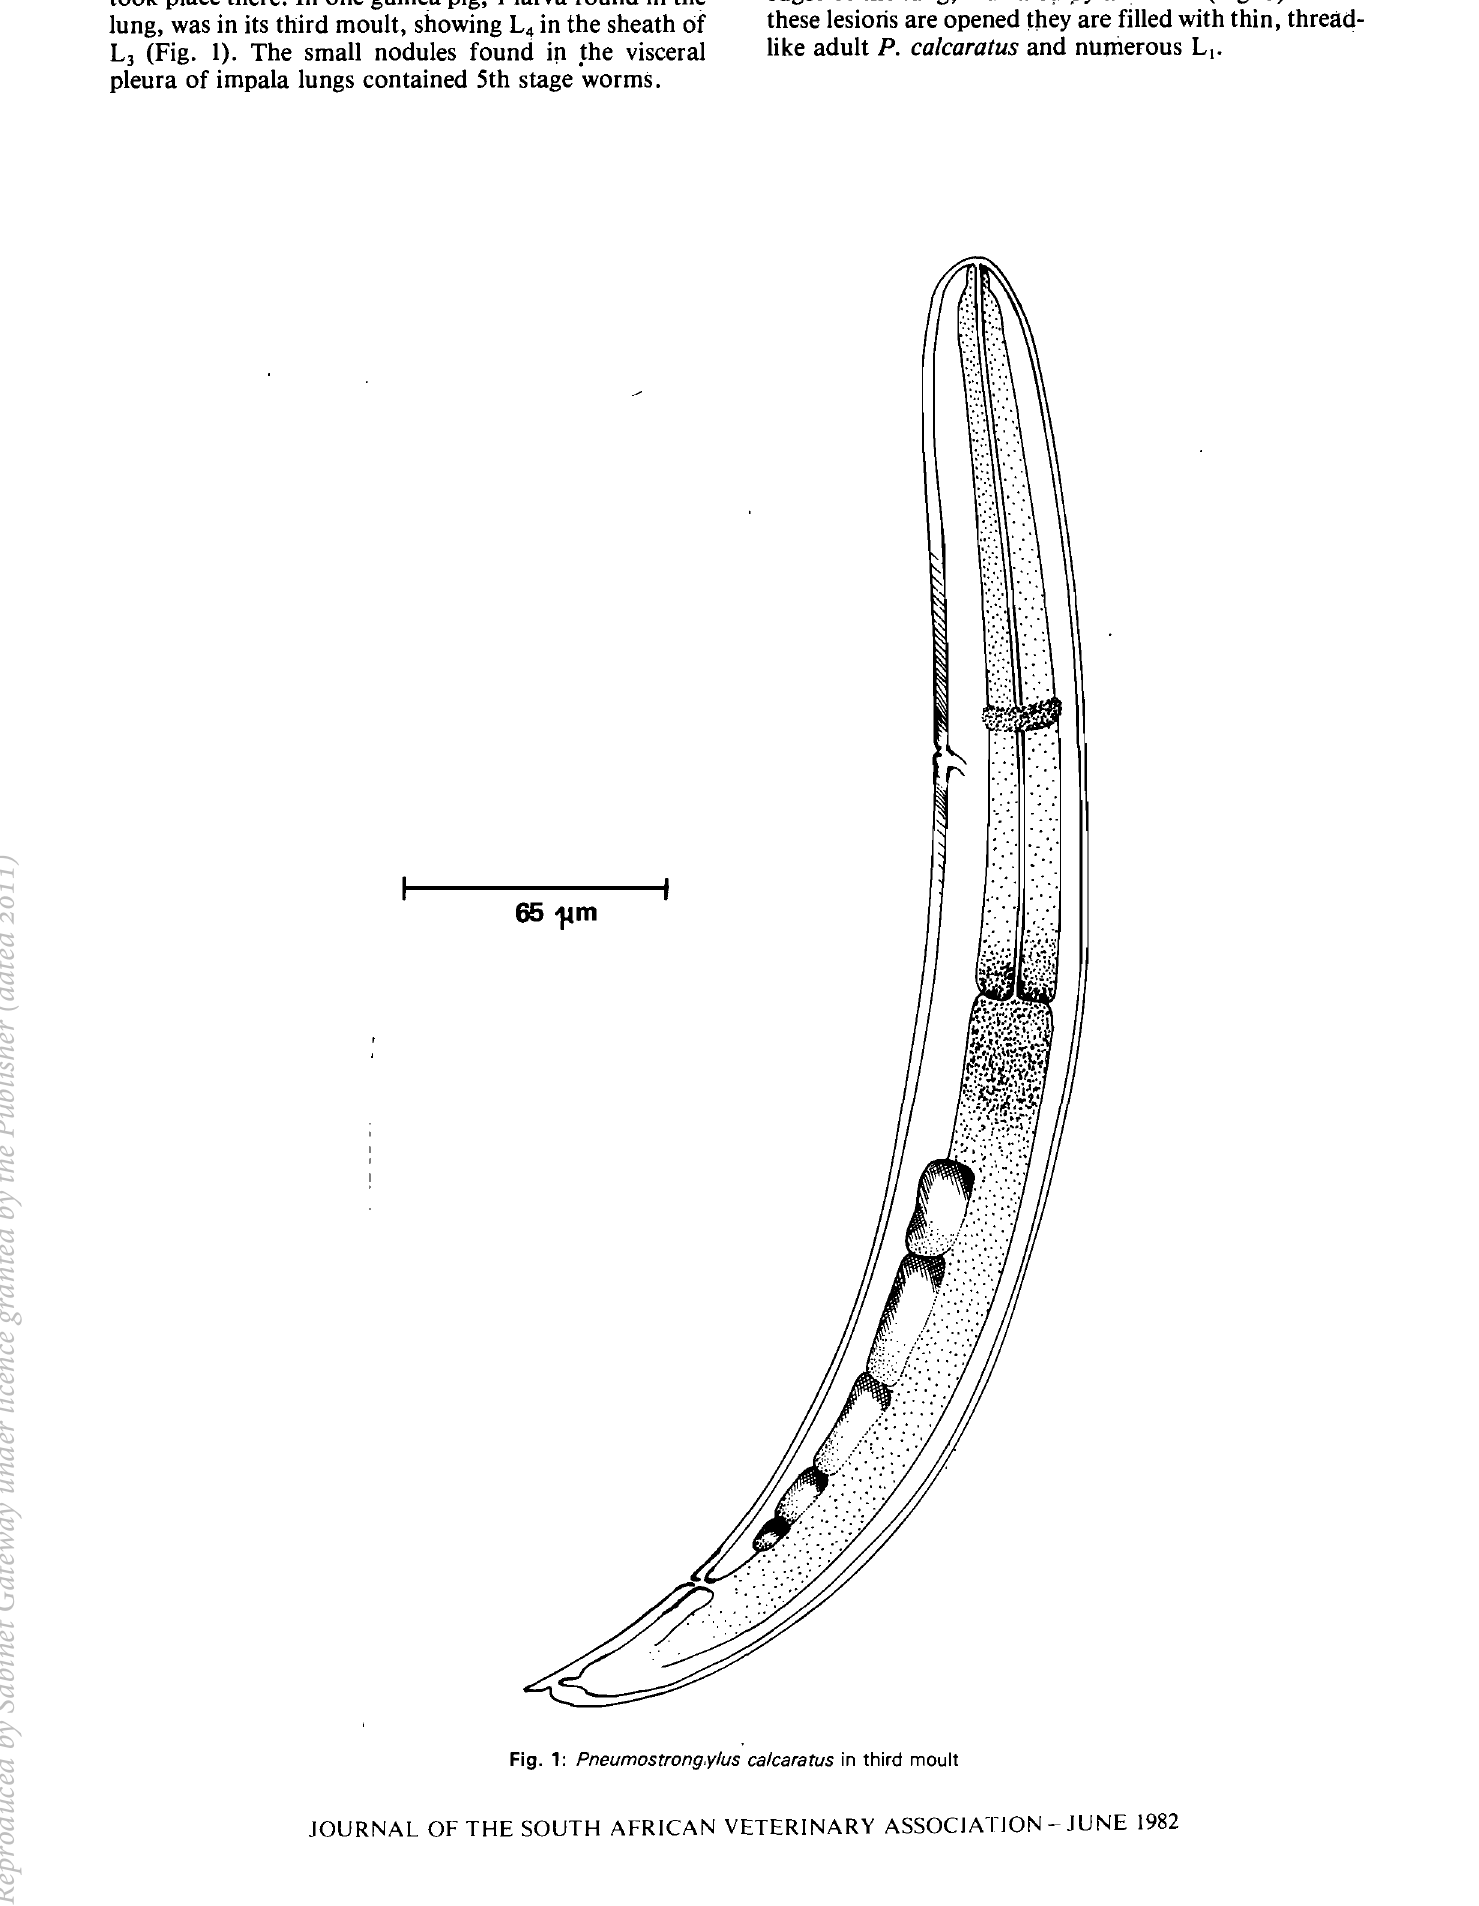
Fig. 1: Pneumostrong,ylus calcaratus in third